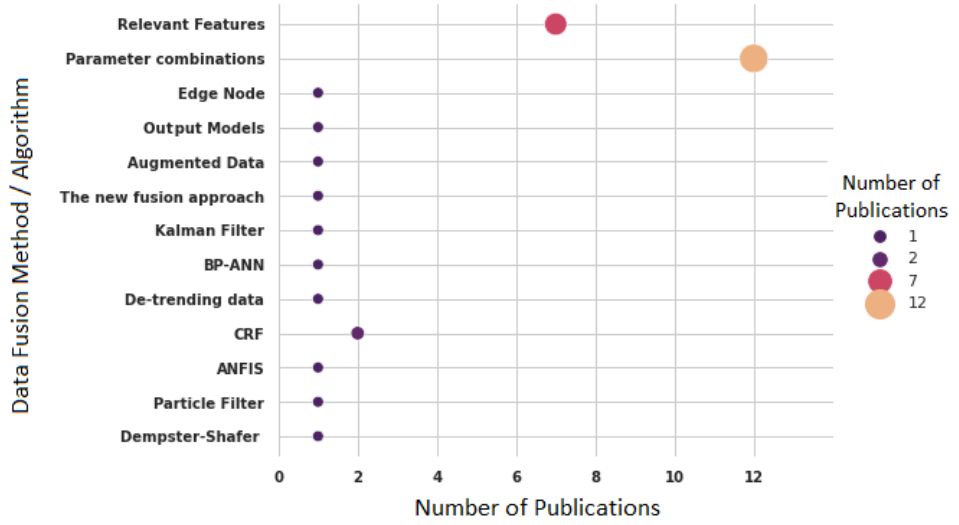
Figure 16. Data fusion methods/algorithms reported in the selected